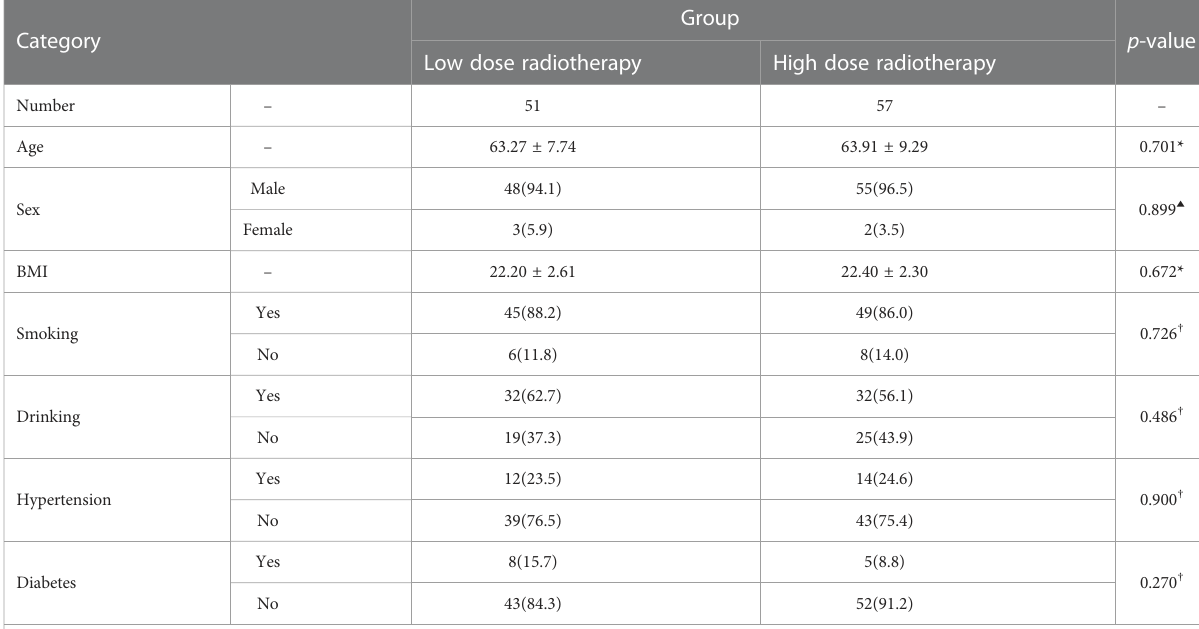
TABLE 1 Demographic and clinical characteristics of different radiotherapy dose groups.